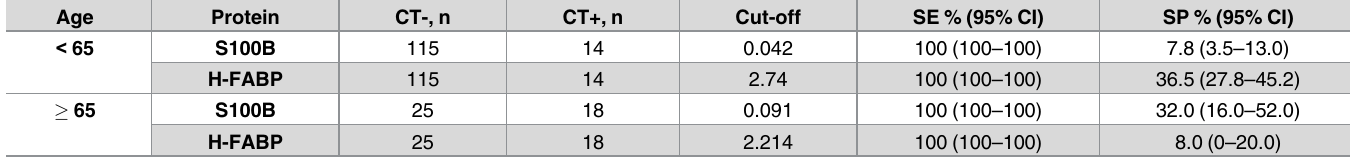
Table 4. The performances of H-FABP and S100B biomarkers at 100% sensitivity, (cid:20) 6 h post-trauma, dichotomised into younger and older patients.